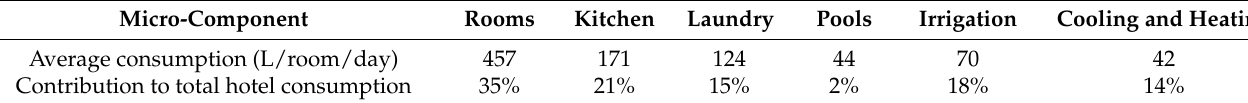
Table 2. Average daily water consumption for each micro-component.